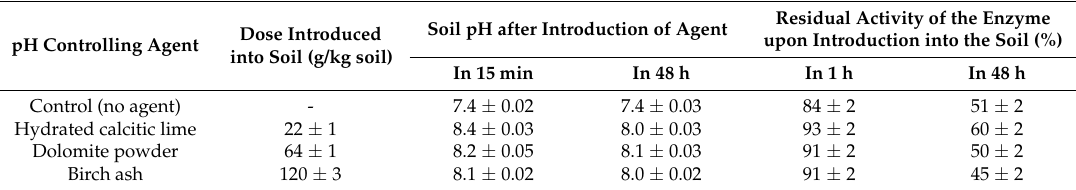
Table 1. The choice of pH controlling agent in the course of choosing the scheme of applying His 6 -OPH for Chlorpyrifos destruction in